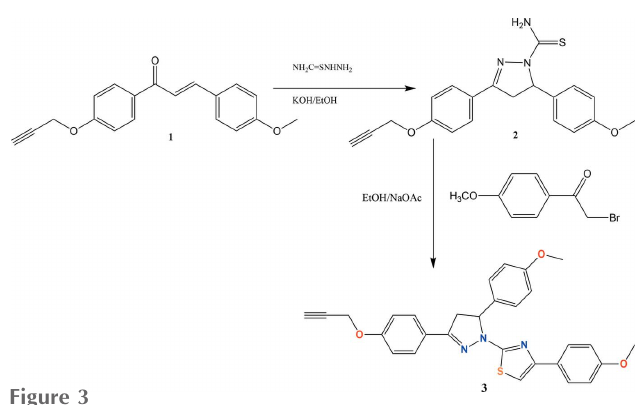
Figure 3 Reaction scheme showing the synthesis of the title compound 3